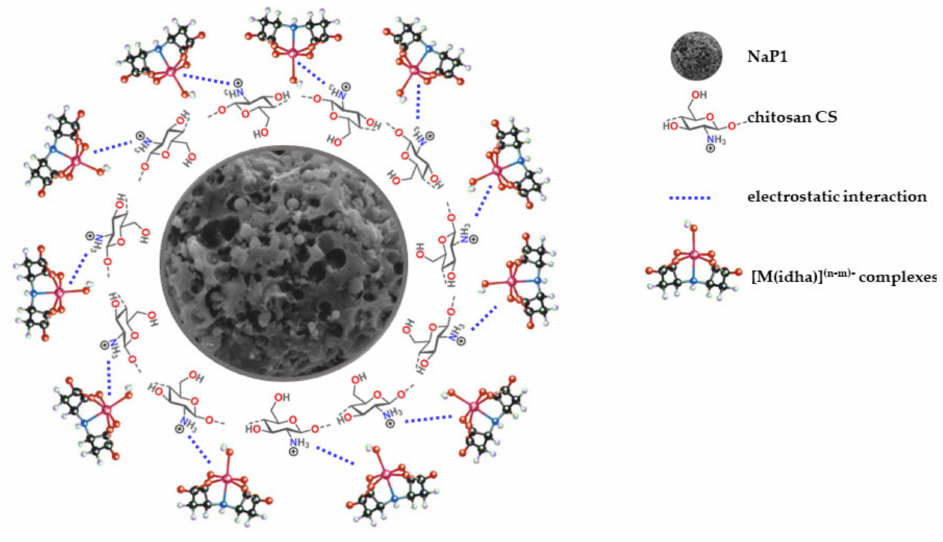
Figure 9. Mechanism of sorption of [M(idha)] (n − m) − complexes onto